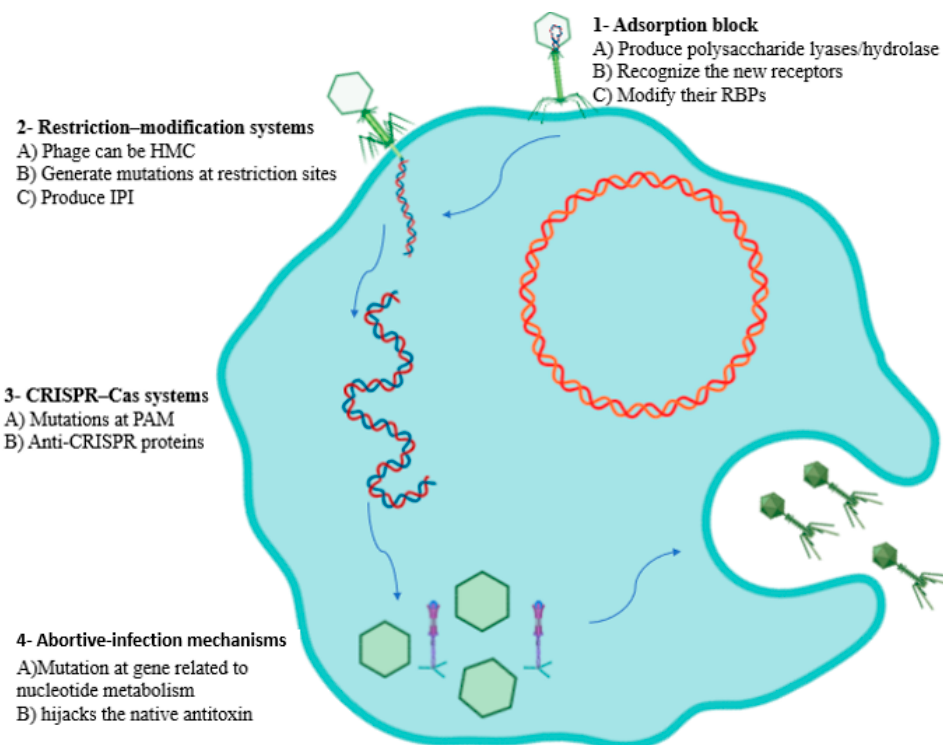
Figure 1. Phage interruption mechanisms against bacterial resistance. The figure shows the four steps of the phage life cycle where it responds to bacterial host cell defense.